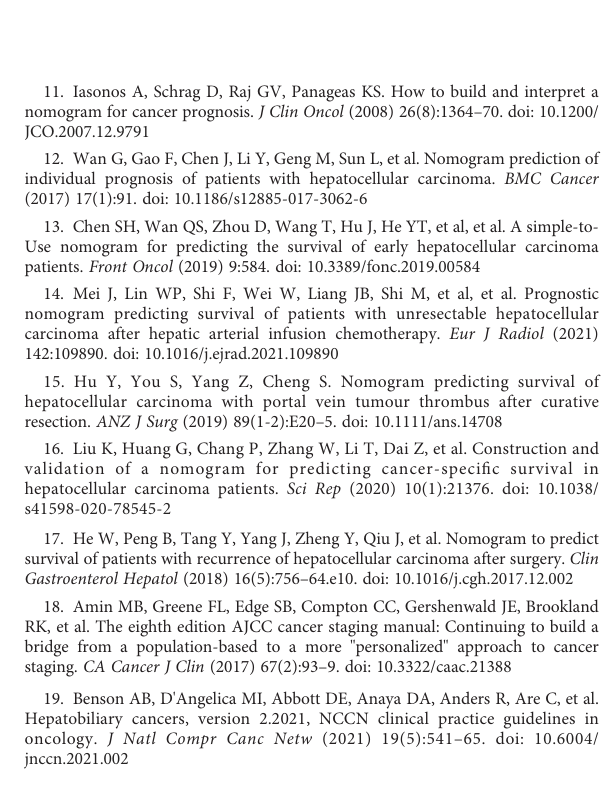
SUPPLEMENTARY FIGURE 1 Kaplan – Meier curves of OS of patients in the training cohort and validation cohort. SUPPLEMENTARY FIGURE 2 Kaplan – Meier survival curve strati fi ed by a respective cut-off value for each variable in alcohol related hepatocellular carcinoma patients. SUPPLEMENTARY TABLE 1 Treatment of alcohol related hepatocellular carcinoma patients during